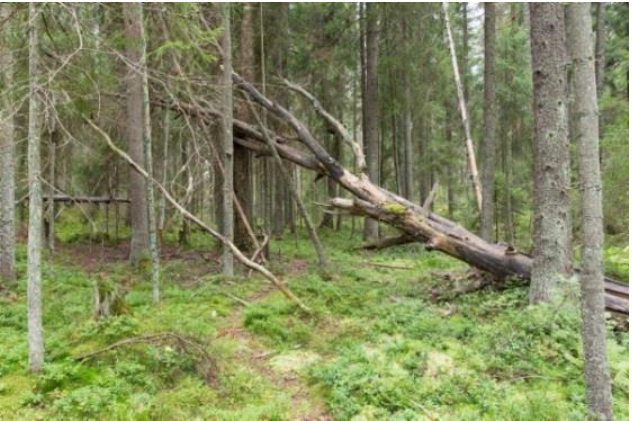
Figure 2. The old-growth forest (Pristine). This picture was published in Reference [66].